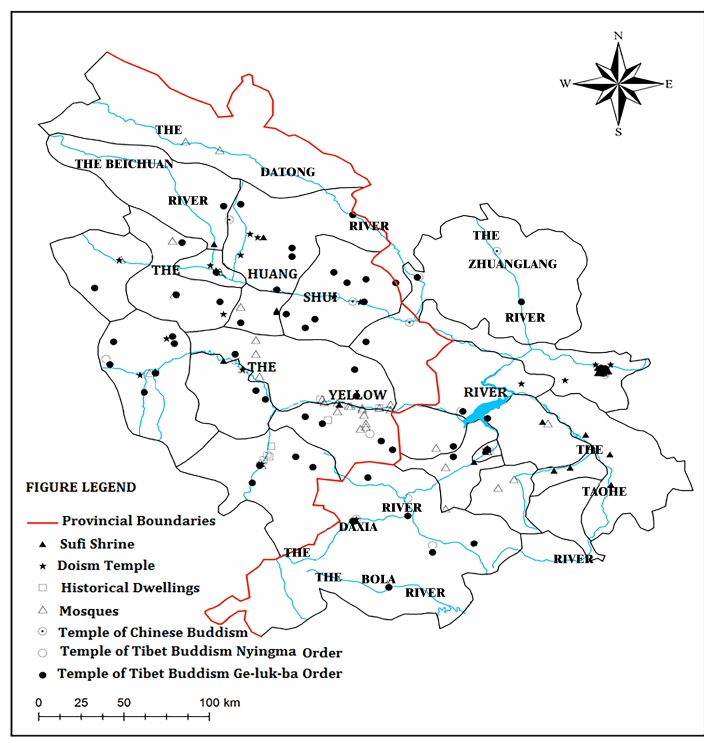
Figure 1. Rivers and Religious Sites of the He-Huang Area (Map by Guo Lanxi,